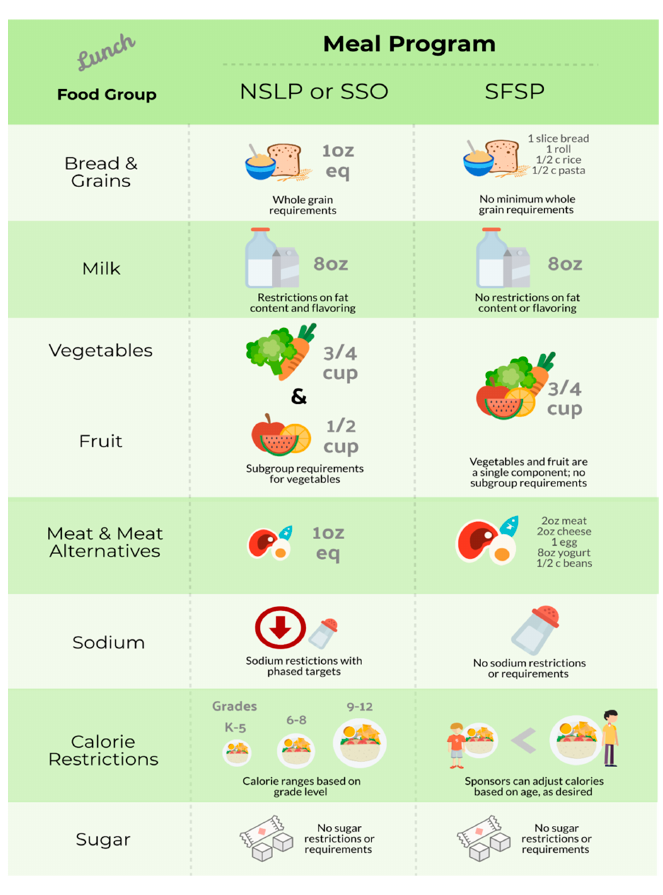
Figure A1. Meal pattern requirements † for meals served through the National School Lunch Pro- gram and Seamless Summer Option* compared to Summer Food Service Program. Adapted with permission from the Healthy Eating Research Strengthening the Impact of USDA’s Child Nutrition Summer Feeding Programs During and After the COVID-19 Pandemic brief [47]. Notes: * Sites serv-